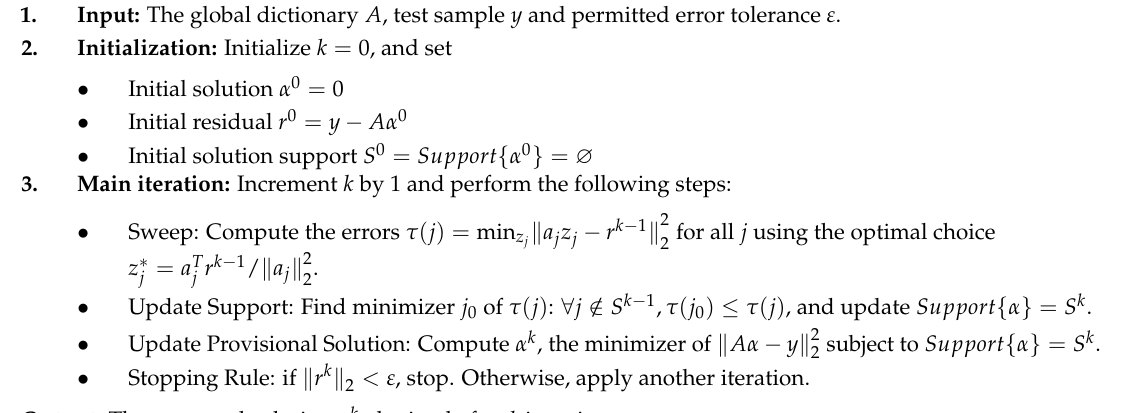
Algorithm 1 Orthogonal matching pursuit (OMP)